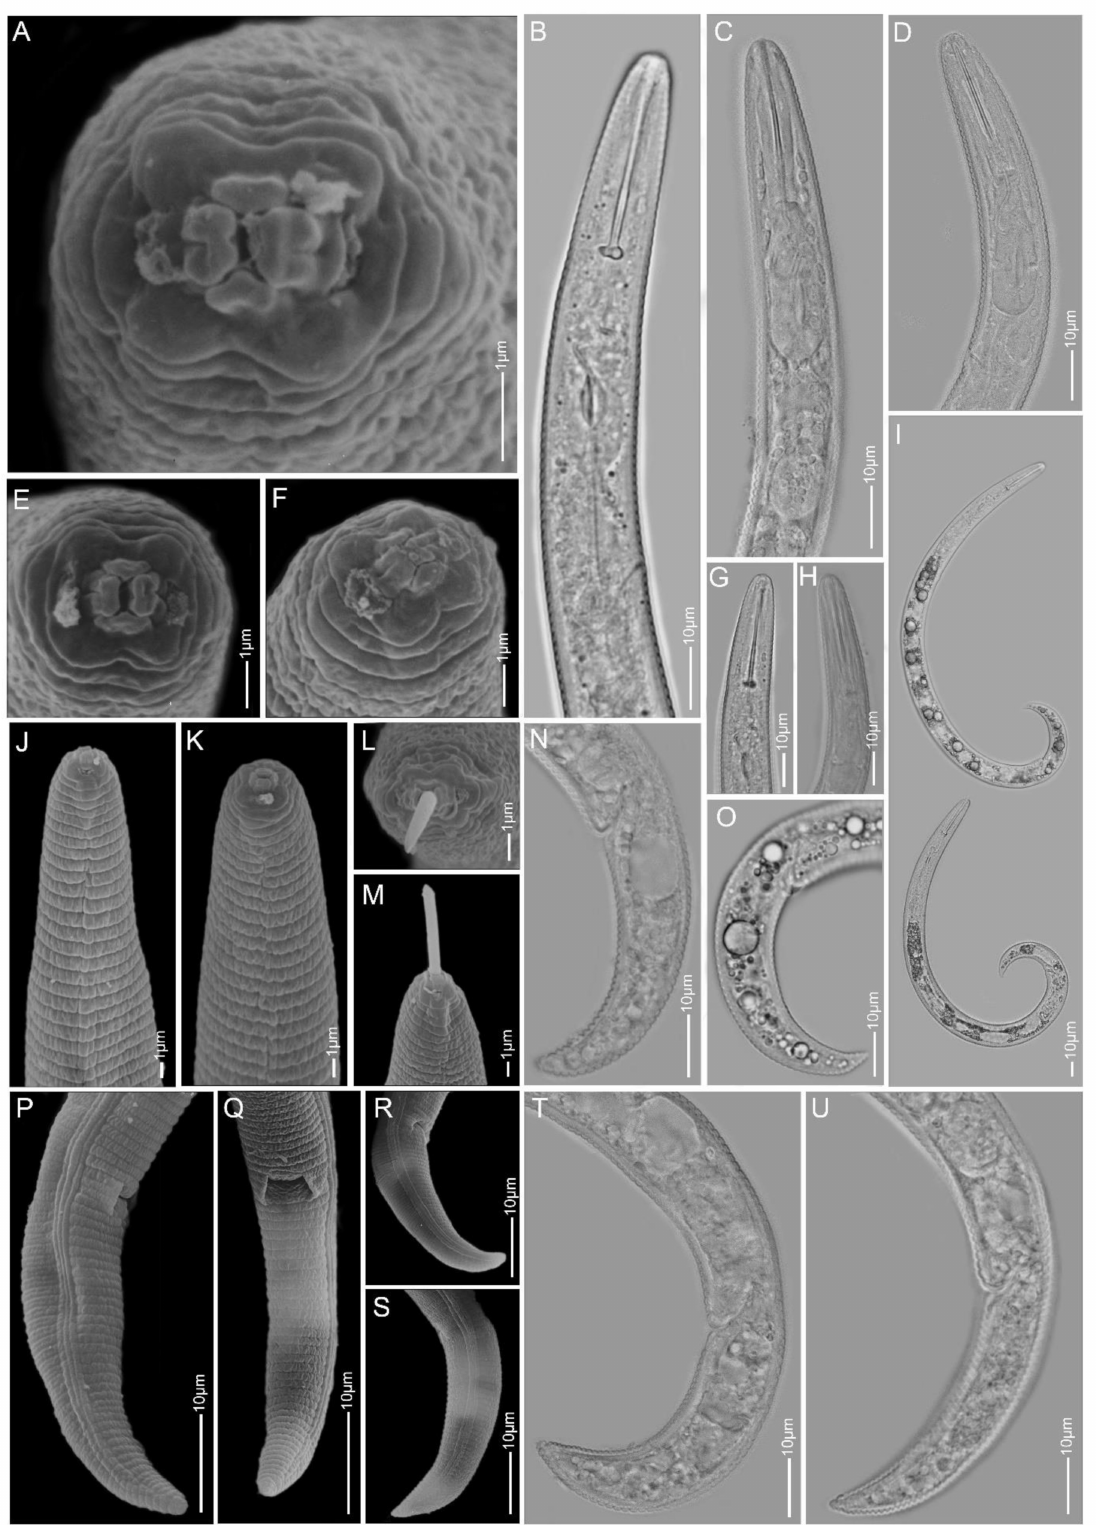
Figure 8. Light and scanning electron microscopy images of Paratylenchus nanus females: ( A , E , F , L ) face view; ( B – D , G , H , J , K , M ) anterior region; ( I ) total body; ( N , O , P – U ) tail